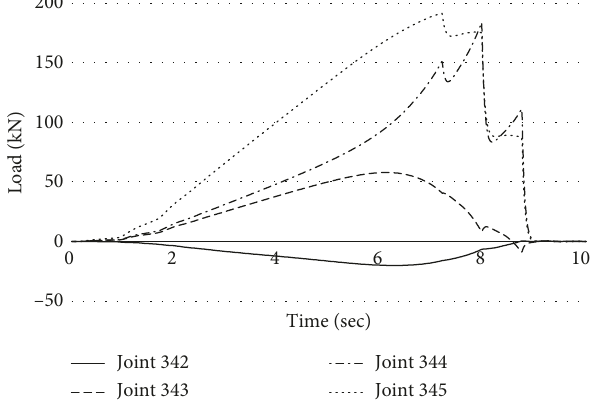
Figure 10: Loads measured by BWIM bearings at the exit side (speed � 20km/h).